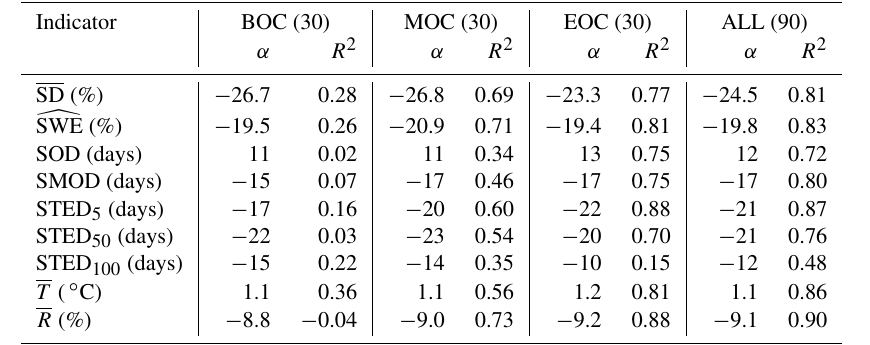
Table 5. Slope ( α , unit indicated inside brackets) and determination coefficient ( R 2 , no unit) of linear regressions of the changes in indicators between BOC, MOC, EOC or ALL and the reference period (1986–2005) and corresponding global temperature rise since 1986–2005. P is not shown. The number of values used for each regression is indicated inside brackets.